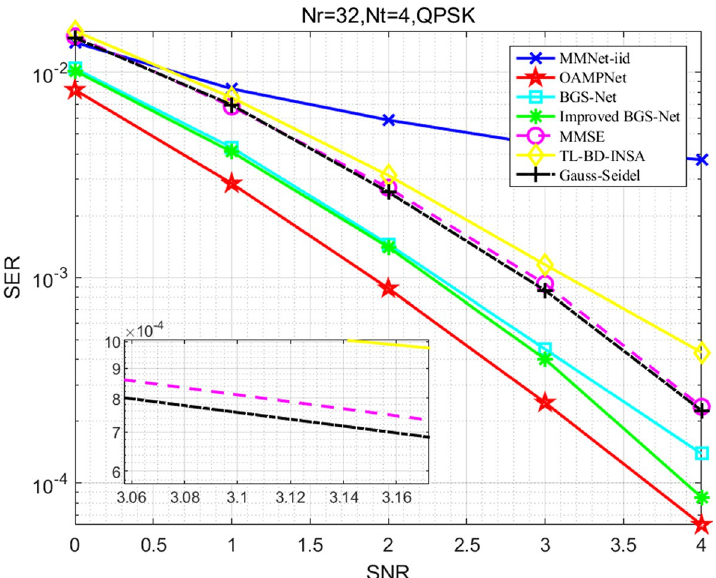
Fig. 20 SER performance comparison of different algorithms for N t = 4,N r = 32 , QPSK, MAUE system with ξ r = 0, ξ t =